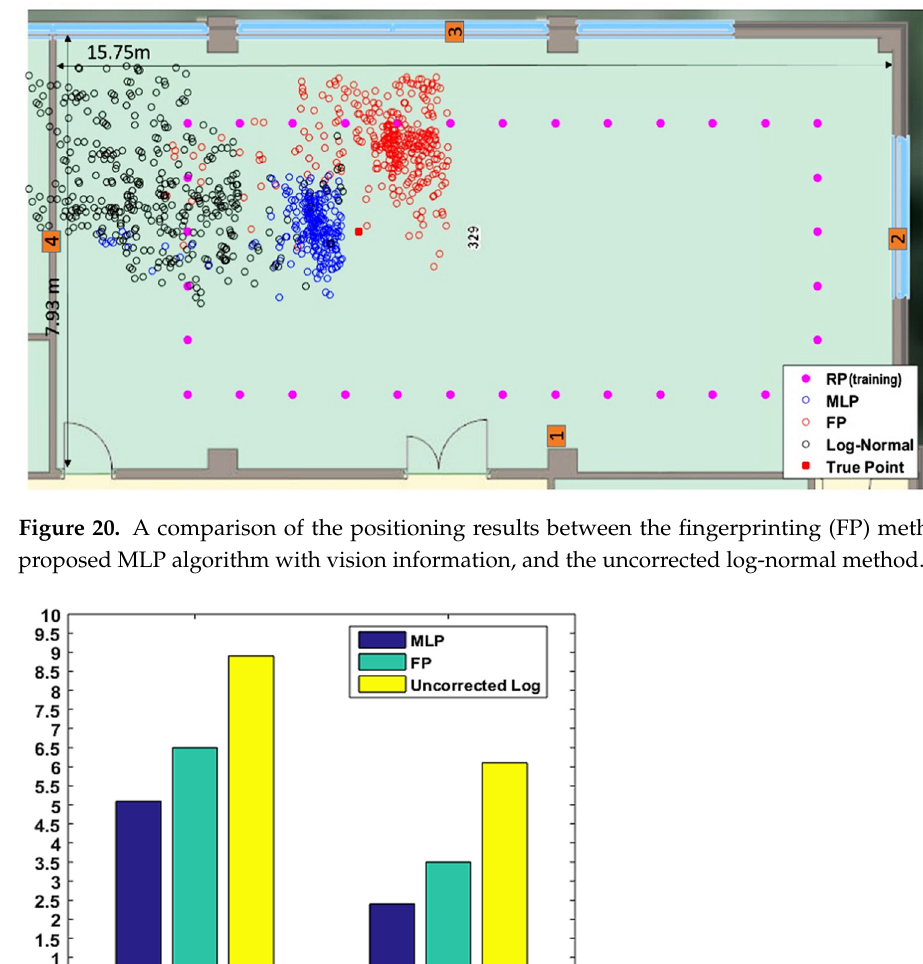
Figure 21. Comparison of the positioning maximum and RMSE error. Considering the use of the trilateration positioning method and covering almost 128 m 2 lab area size, we selected four transmitters for this study. The number of transmitters by other groups has also been based on the size of their test areas. In [34], five transmitters were used for 120 m 2 with no furniture, and in [23], four transmitters were deployed for a 100 m 2 office area. The preference to mount the transmitters on the walls, rather than the corners, inside our test environment, was to provide a maximum propagation response in a wider direction. In [21], with three BLE advertising channels, an error of 4.6 m, 90% of the time, was achieved in a conference room with a 16.50 m × 17.60 m size. Another study [20] with one beacon per 9 m BLE deployment achieved 2.56 m 90% of the time in the corridor area with no complex environment. In contrast, our results in a complex environment including large cabinets, chairs, desks, metal shelves, and racks (Figure 9) with a 126 m 2 area show a 2.4 m RMSE position error when using the MLP algorithm.